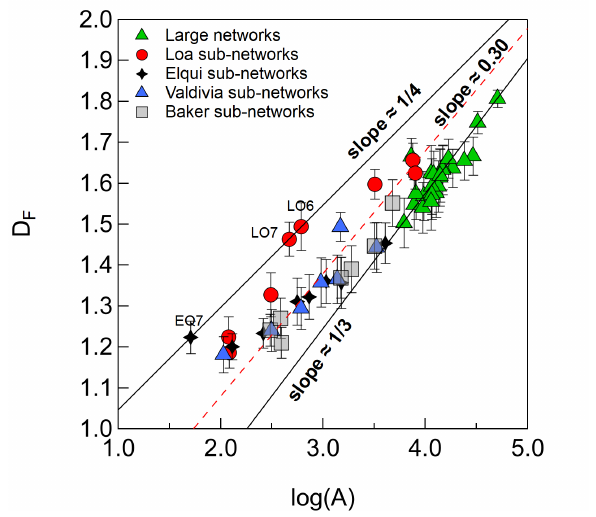
Figure 7. D F versus log ( A ) for large and sub-networks. Continuous lines correspond to linear fits, defining the scaling D F ∝ s · log ( A ) , with s the slope of each curve (=1/4 and 1/3 for each dataset). The slope of the linear central fit, dashed line, is arbitrary ( s ≈ 0.30).